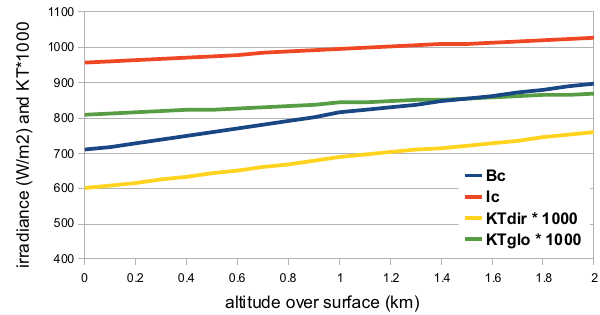
Figure 1. Example of change in irradiance ( B c for direct and I c for global) and clearness index (KT) with altitude. KTdir and KTglo are direct and global